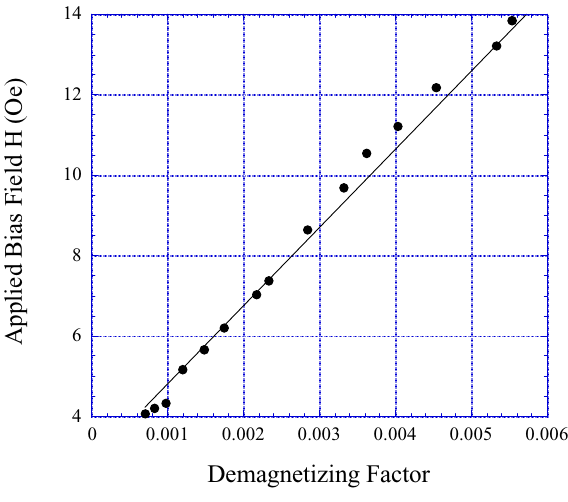
Figure 19. The optimal bias field increases linearly with the demagnetizing factor of the sensor.